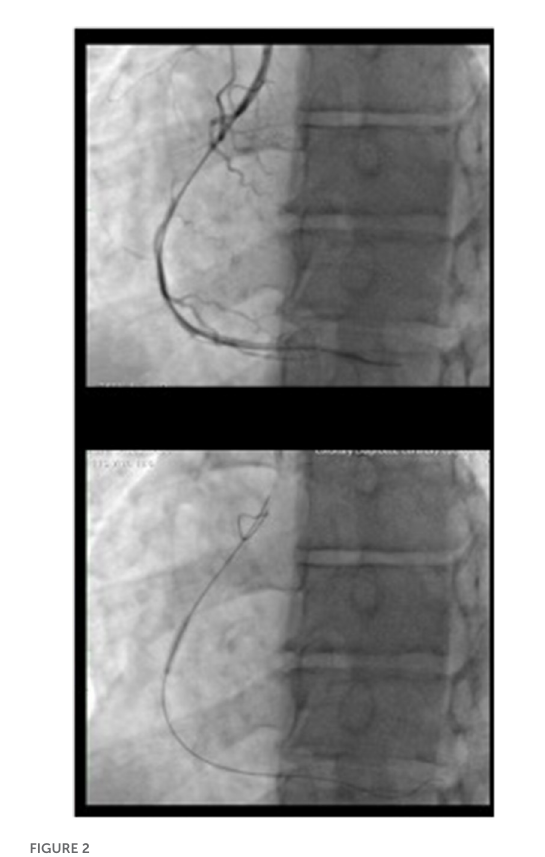
FIGURE2 CTO treatment procedure: The occlusion was crossed with a tapered polymeric guidewire supported by microcatheter. The flow was restored after a dilatation of the occlusion with 1.5 x 12 balloon. Than a dilatation with a 2 x 15 balloon at 10 atm was performed.